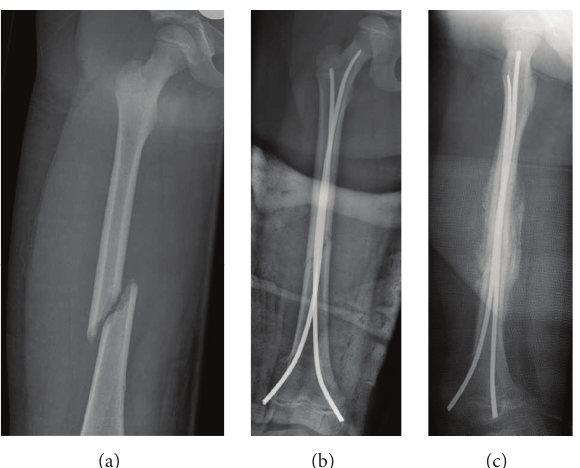
Figure 6: Right femoral middle shaft fracture that was surgically treated with good results. Hypertrophic bone callus